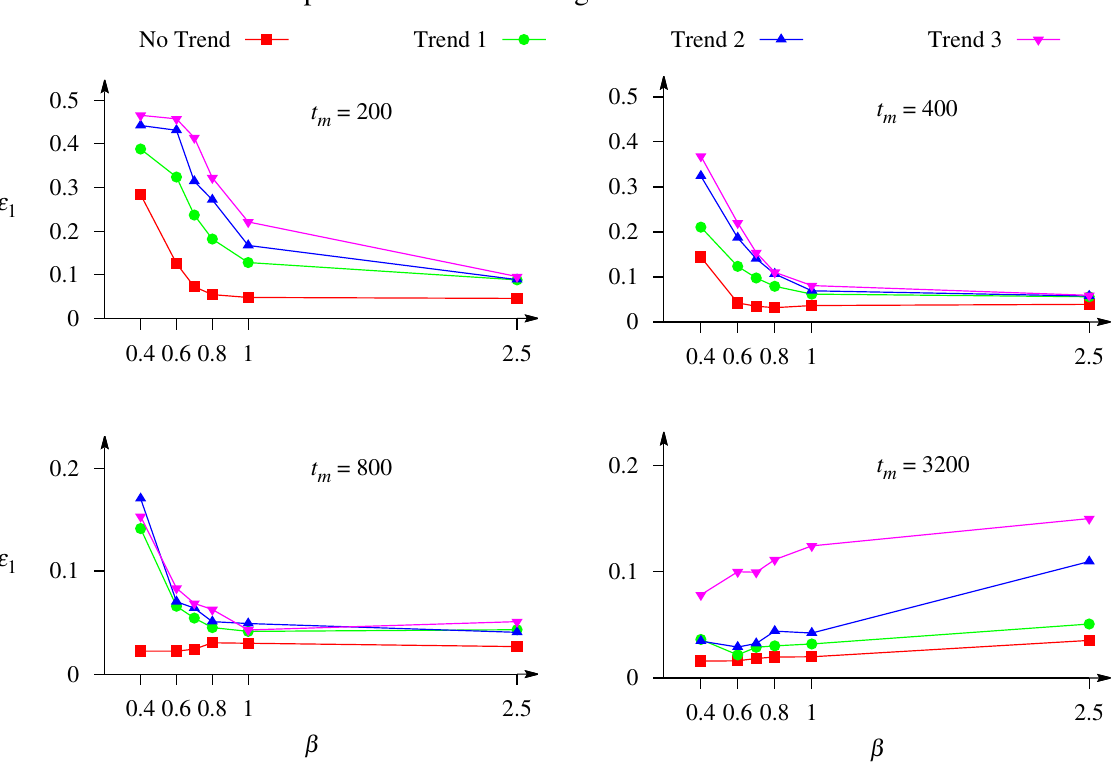
, of the evaluation of the concentration, c , of the substrate, 1 1 , of the biosensor operation when the m